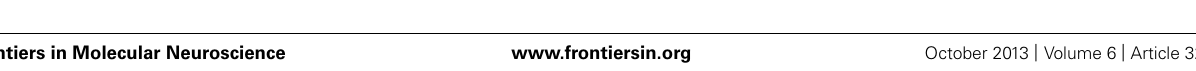
Frontiers in Molecular